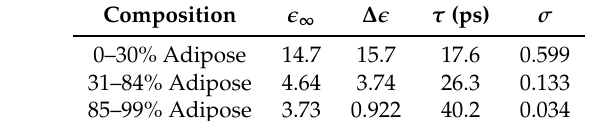
Table 2. Median of fitted Debye parameters for ablated (damaged) breast tissue.